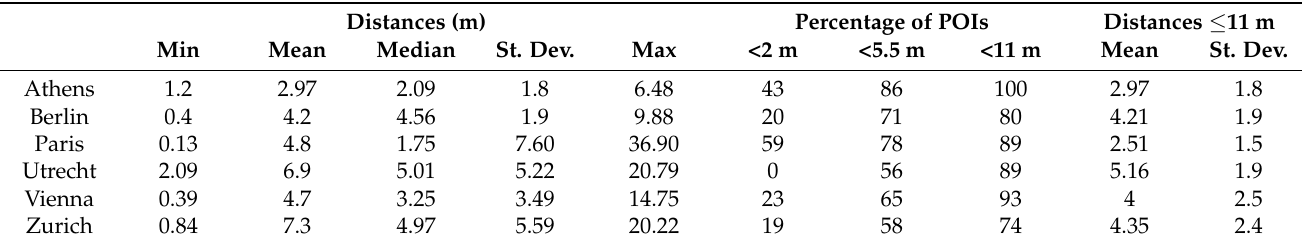
Table 7. Statistics for POI distances from railways (Check 6).